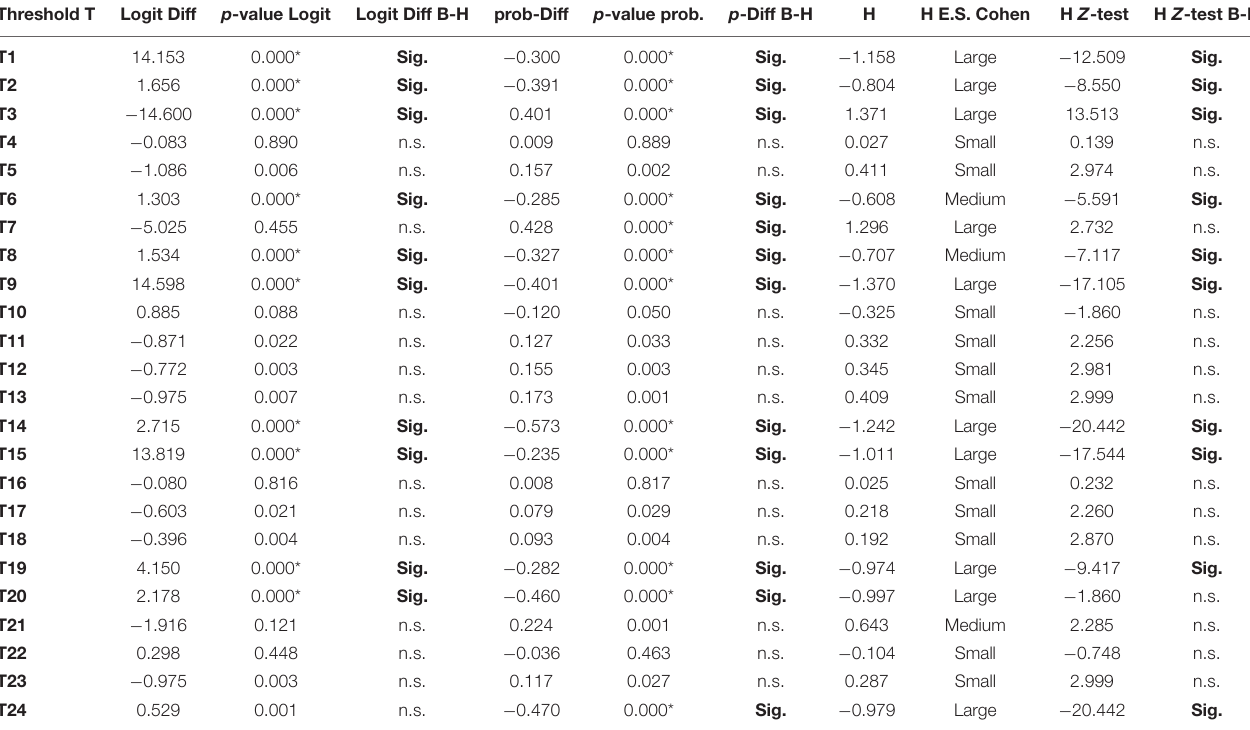
TABLE 7 | Differences between thresholds across waves (2016 vs. 2018) using logit and probability difference tests. Threshold T Logit